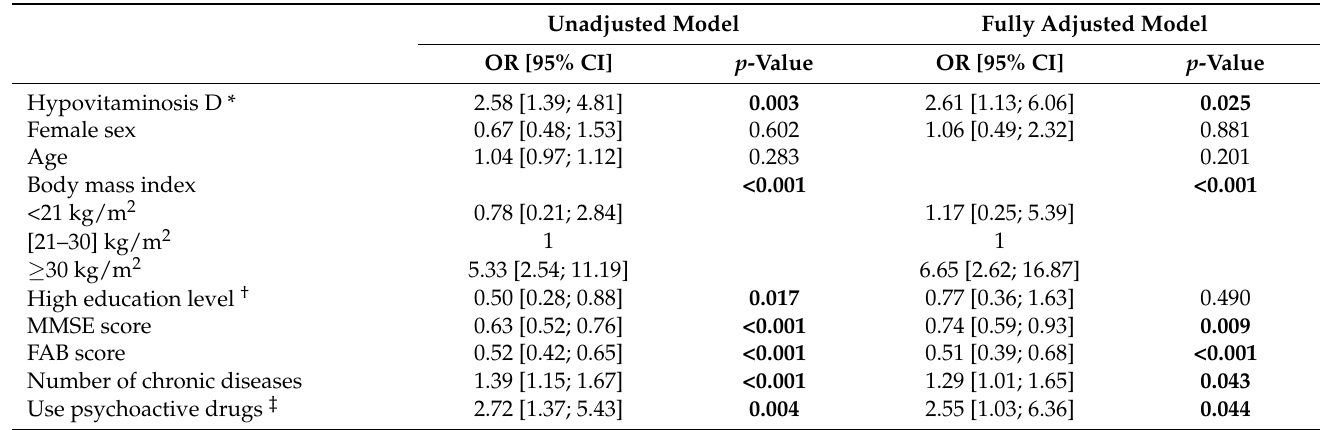
Table 3. Univariate and multiple logistic regressions showing associations between Motoric Cognitive Risk syndrome (dependent variable) and participants’ characteristics including hypovitaminosis D (independent variables) ( n =